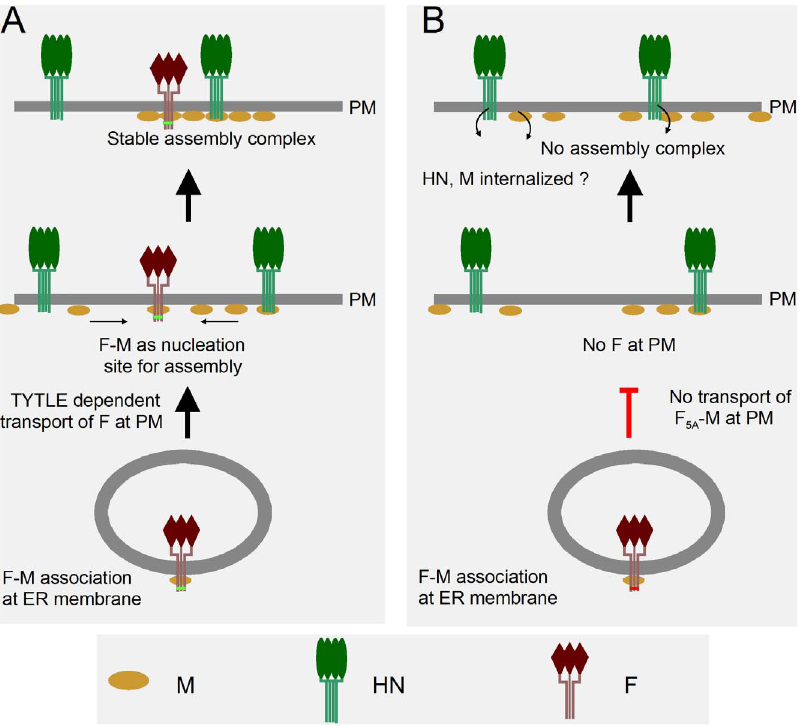
Figure 9. Possible model depicting formation of the viral assembly complex dependent on F. Only the viral membrane proteins F, HN and M are considered for simplicity (see Text for further explanations). A . Wild type F interacts with a fraction of M at the level of the ER membranes. This F-M protein complex is transported to the plasma membrane in a TYTLE (small green rectangle) dependent manner. At the cell surface (PM), F-M defines a nucleation site for more M condensation (a fraction of M positioned at PM without F interaction) and for HN recruitment (likely through M). Nucleocapsids (not shown) may now bind to a stable assembly complex made of the 3 membrane viral proteins leading to virus particle budding. B . When F is mutated (red rectangle), F-M complex remains in ER due to the absence of the TYTLE motif. Absence of assembly nucleation site at PM results in disorganization of M and HN patterns at PM and stable assembly complex capable of binding nucleocapsids is not formed leading to lack of virus particle